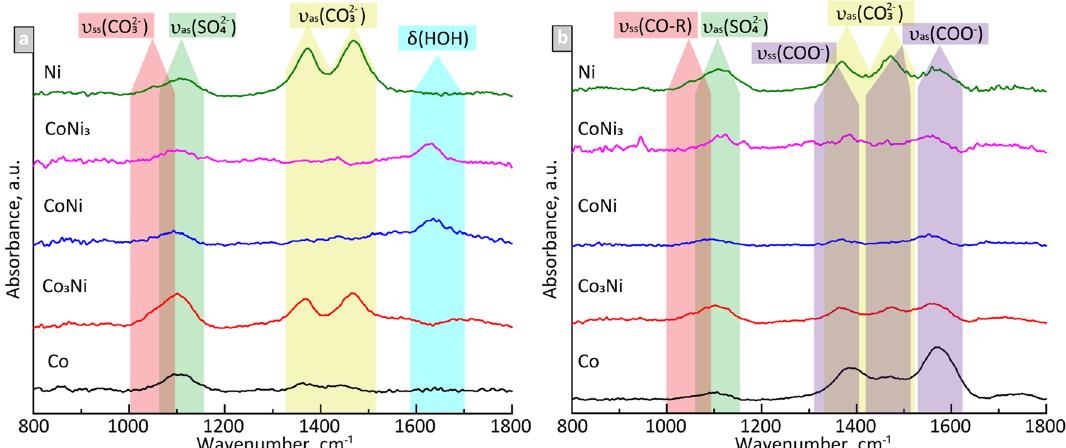
Figure 7. ATR-FTIR spectra of the Co- and Ni-containing NPs exposed for 3 h in ( a ) synthetic FW without NOM and ( b ) FW with